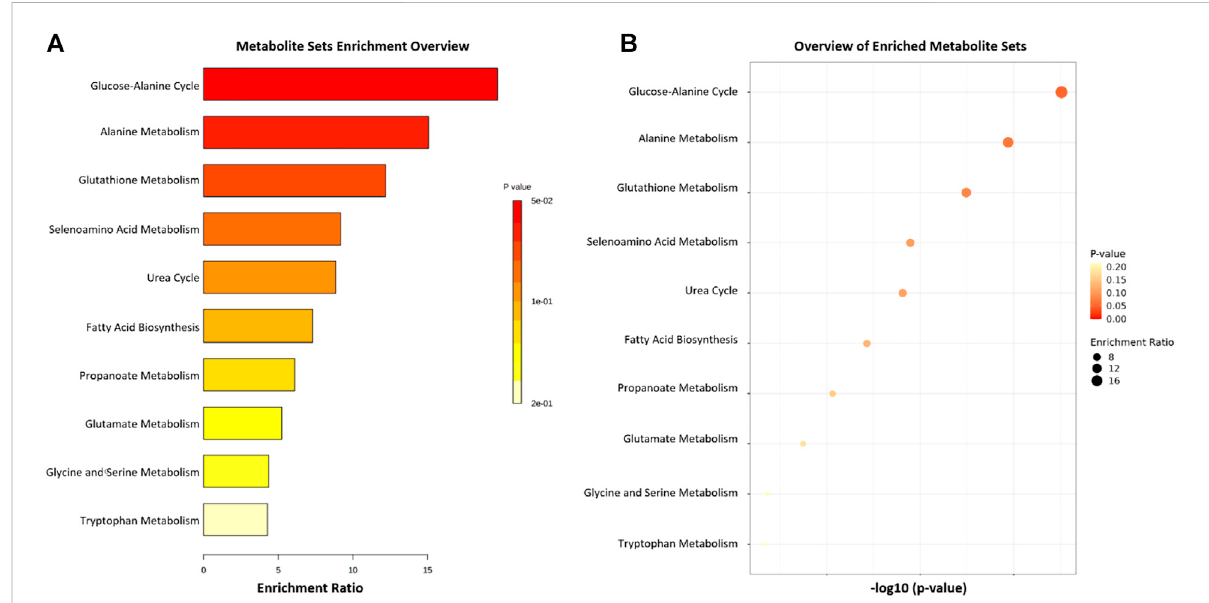
FIGURE 8 List of the 11 main pathways related to the four metabolites compared between the 6-OHDA, 6-OHDA + P and Sham groups. (A,B) Metabolite enrichment analysis indicating major metabolic pathways involved.